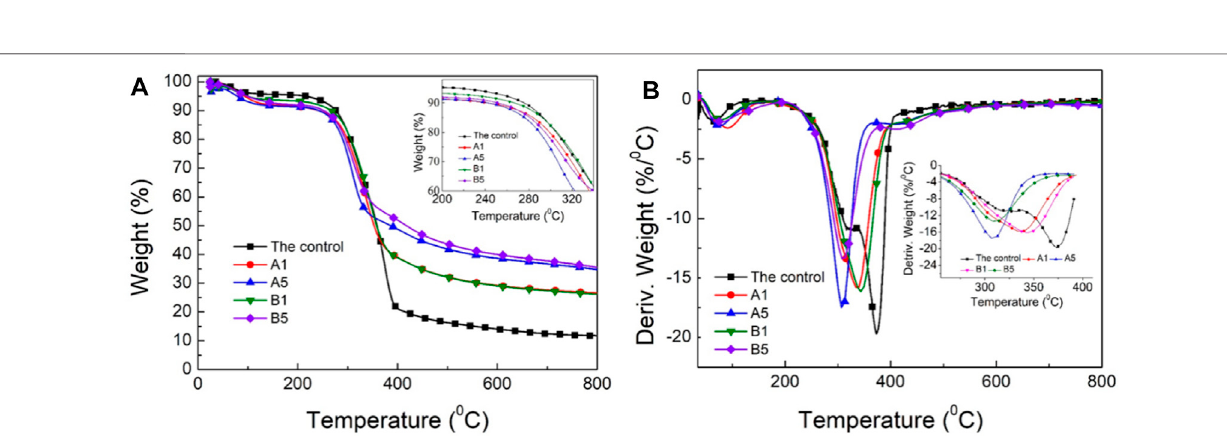
FIGURE 4 | Weight curves (A) and DTG curves (B) of bamboo specimens before and after self-assembly with PA-PEI in N 2 atmosphere.